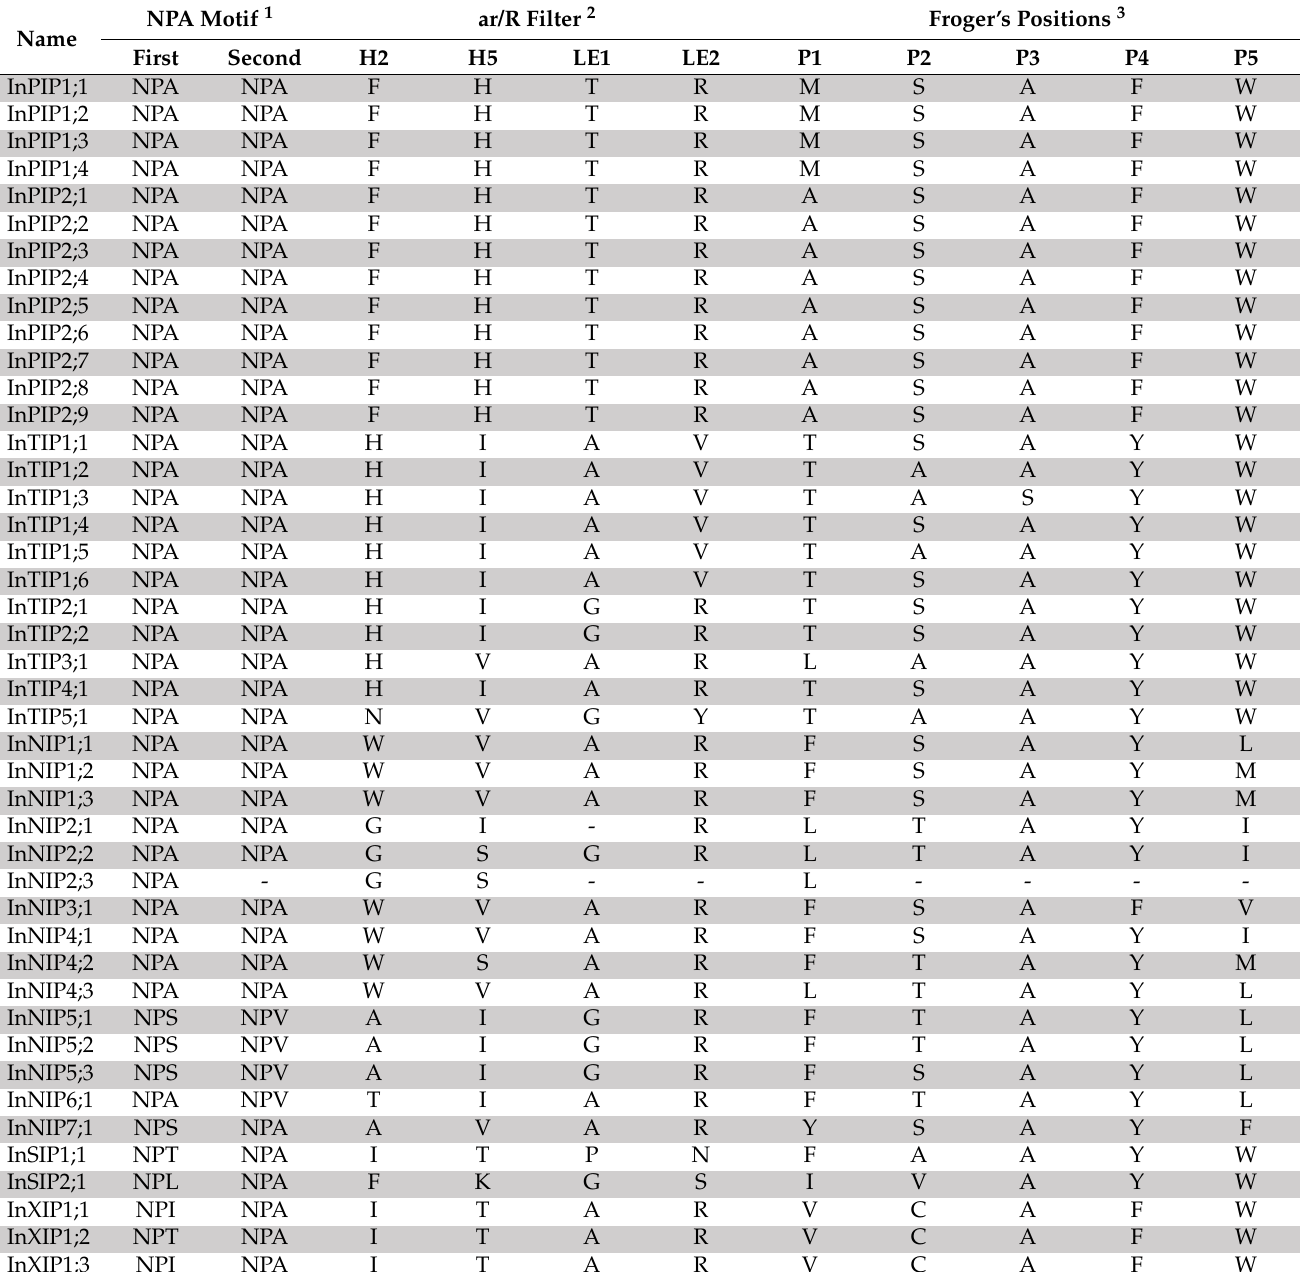
Table 2. Amino acid composition of the NPA motifs, ar/R filters (H2, H5, LE1, and LE2), and Froger’s positions (P1–P5) in Japanese morning glory